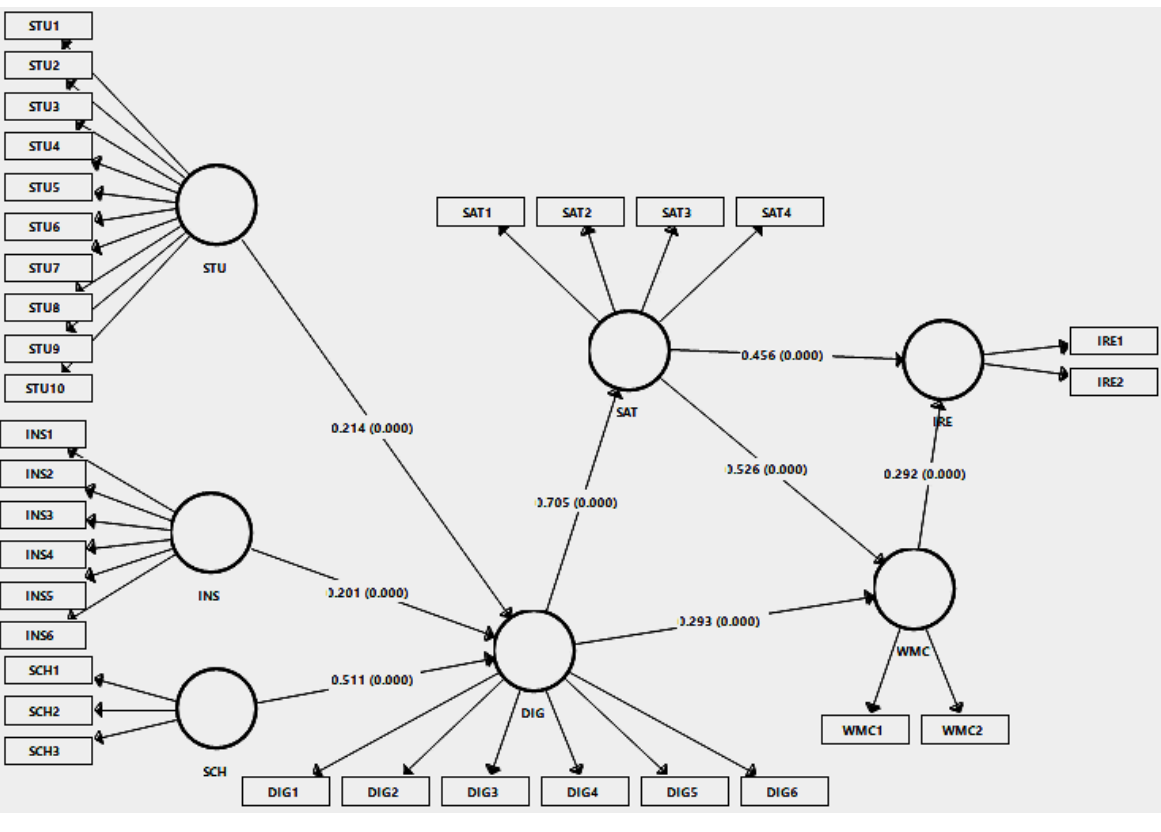
Figure 4. Estimation results